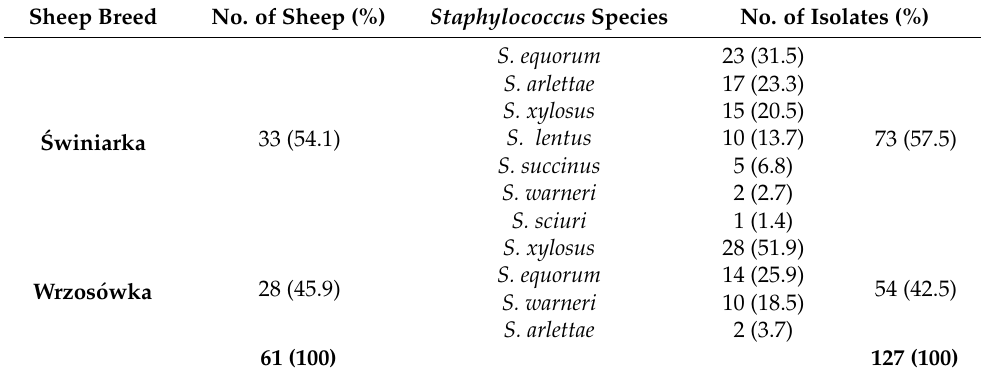
Table 2. Species diversity vs. a source of isolation of staphylococci. Sheep